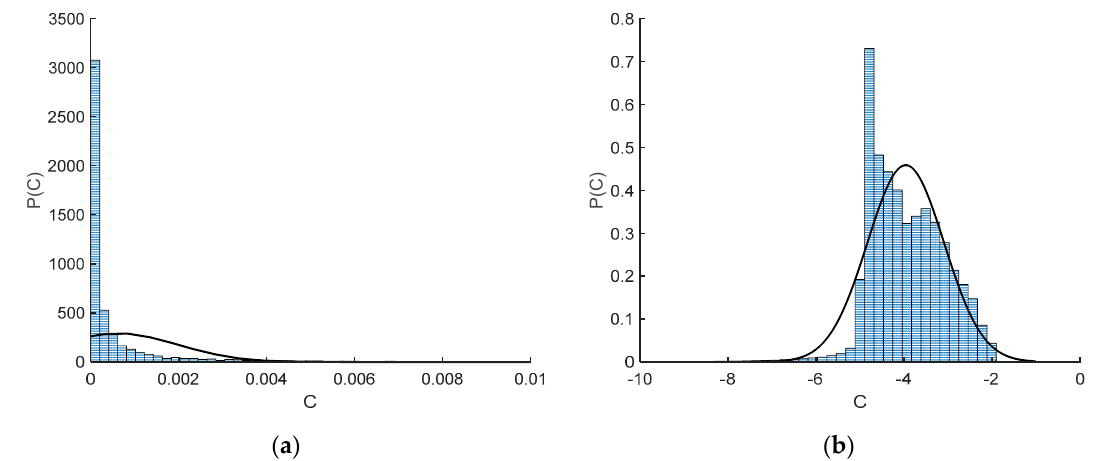
Figure 7. The probability density function (PDF) of oxygen history ( O 2, h ): ( a ) before data pre-processing; ( b ) after data pre-processing.